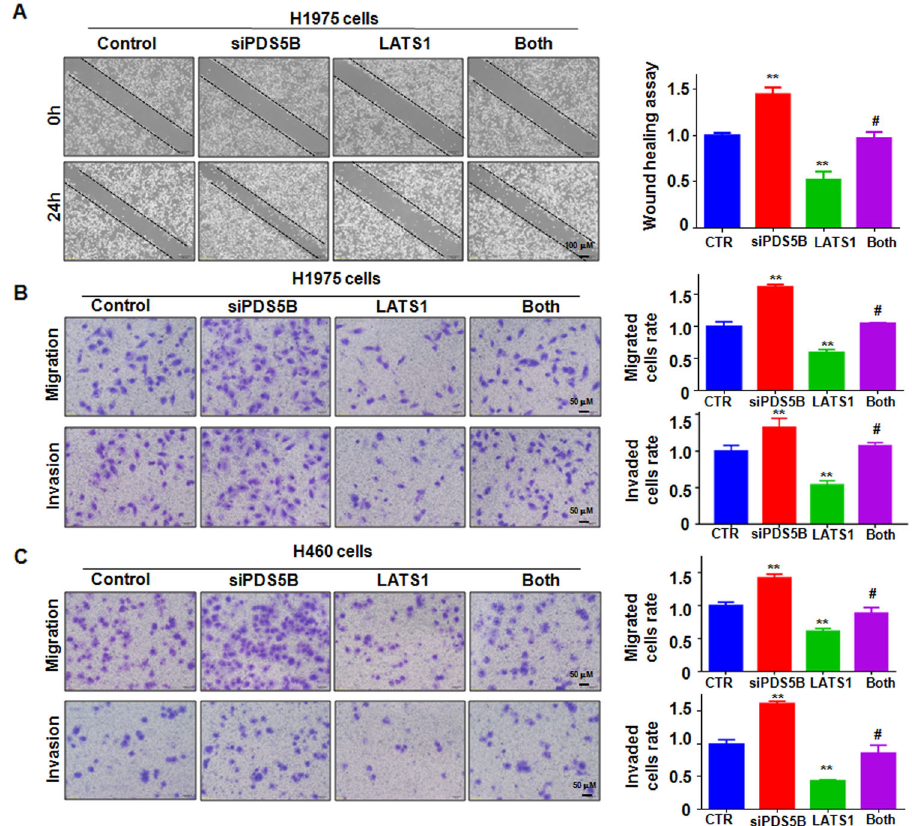
Fig. 5 LATS1 overexpression abrogates PDS5B knockdown-mediated motility. A Left panel: wound closure was examined by wound- healing assays in H1975 cells after co-transfection of LATS1 cDNA and PDS5B siRNA. Right panel: quantitative data of wound closure. ** P < 0.05 vs control group; # P < 0.05 vs PDS5B siRNA alone or LATS1 cDNA alone. Control nonspeci fi c control siRNA and empty vector, siPDS5B PDS5B siRNA, LATS1 LATS1 cDNA, Both siPDS5B + LATS1. B Left panel: cell motility was examined in H1975 cells after co-transfection of LATS1 cDNA and PDS5B siRNA. Right panel: quantitative data of cell motility. ** P < 0.05 vs control group; # P < 0.05 vs PDS5B siRNA alone or LATS1 cDNA alone. C Left panel: cell motility was measured in H460 cells after co-transfection of LATS1 cDNA and PDS5B siRNA. Right panel: Quantitative data of cell motility. ** P < 0.05 vs control group; # P < 0.05 vs PDS5B siRNA alone or LATS1 cDNA alone. Data are shown as mean ± SD from experiments in